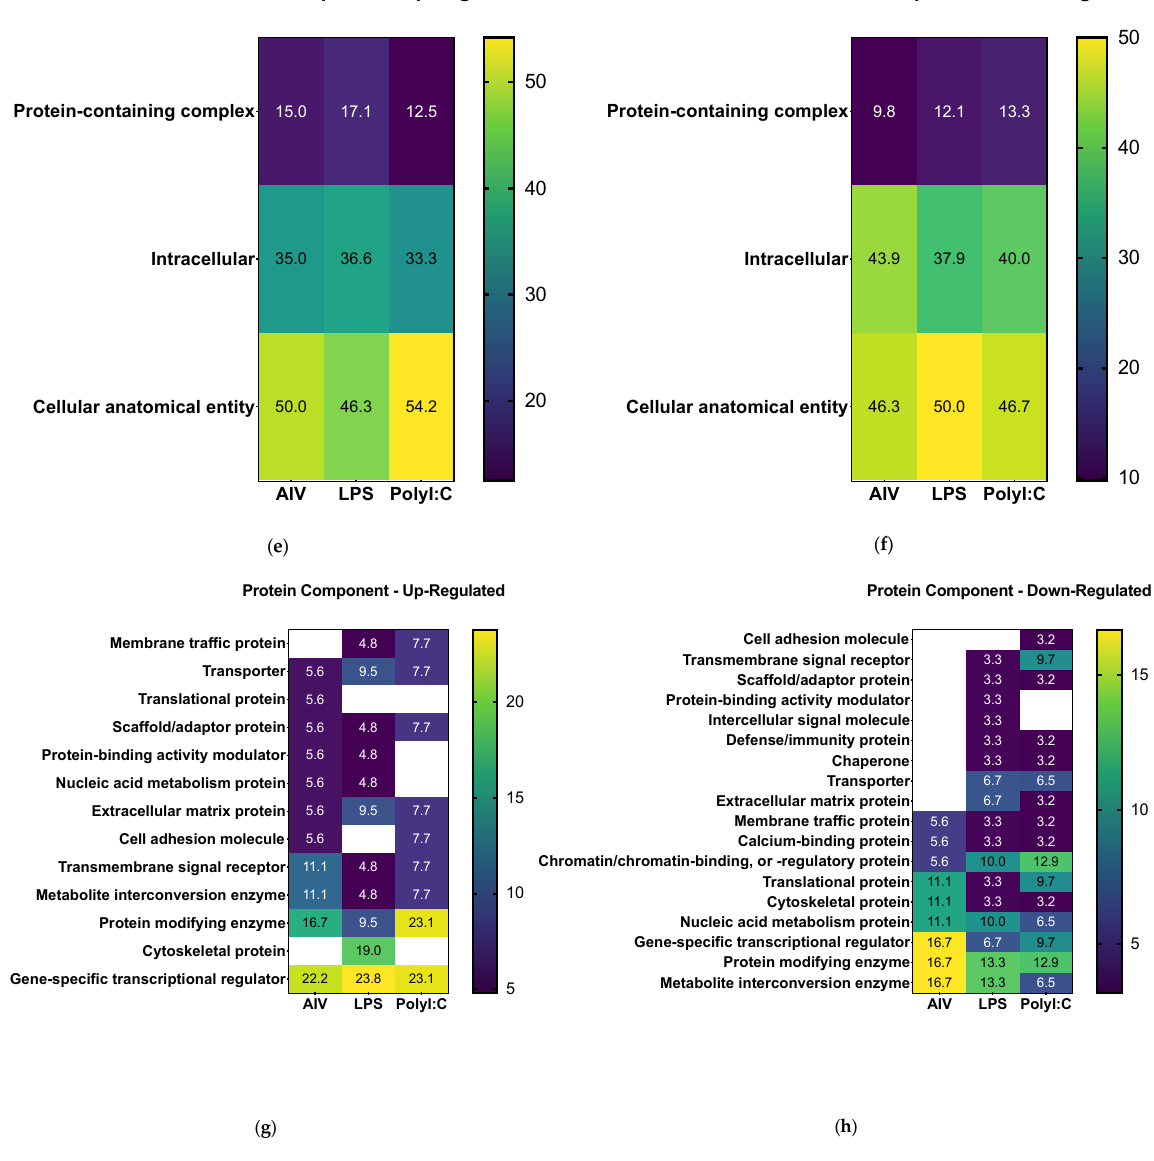
Figure 3. Gene set enrichment analysis of DE proteins of EVs from TOCs treated with AIV, LPS, and polyI:C. Separated by up-regulated and down-regulated proteins, the functional annotation for molecular function ( a , b ), biological process ( c , d ), cellular component ( e , f ), and protein class ( g , h ), respectively, were obtained from the PANTHER classification system database. The color intensities represent the percent gene hits against the total number of hits for each term. Detailed lists of the up- and down-regulated proteins and associated gene ontology terms for AIV, LPS, and polyI:C treatment groups are found in Table S3.